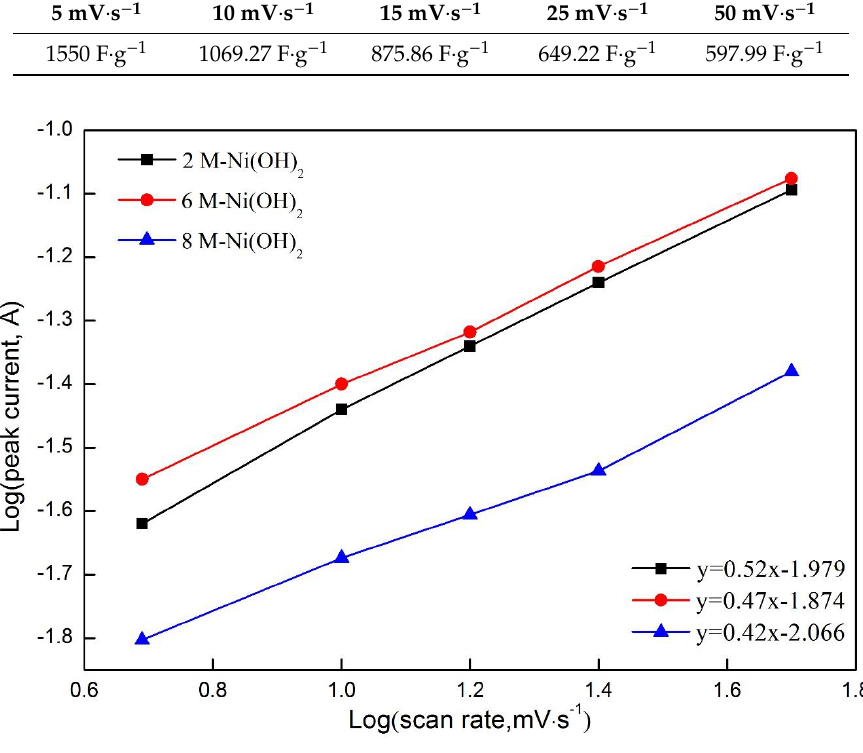
Figure 8. Logarithmic relationship of different concentrations of Ni(OH) 2 samples.